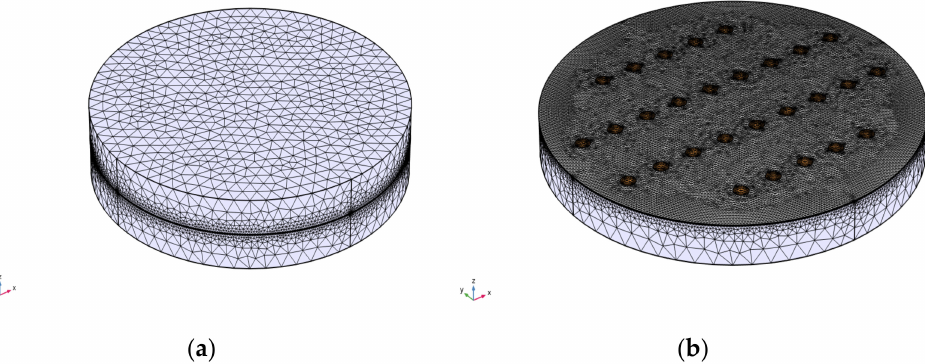
Figure 7. Discretization of the computational domain: ( a ) two copper disks in contact; ( b ) contact spots and the insulating layer of polyethylene (PE) at the interface.